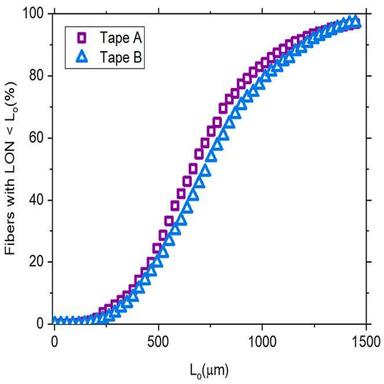
Fraction of fibres with a length of neighbourhood LON lower than the volume scan size Lo, for varying Lo.